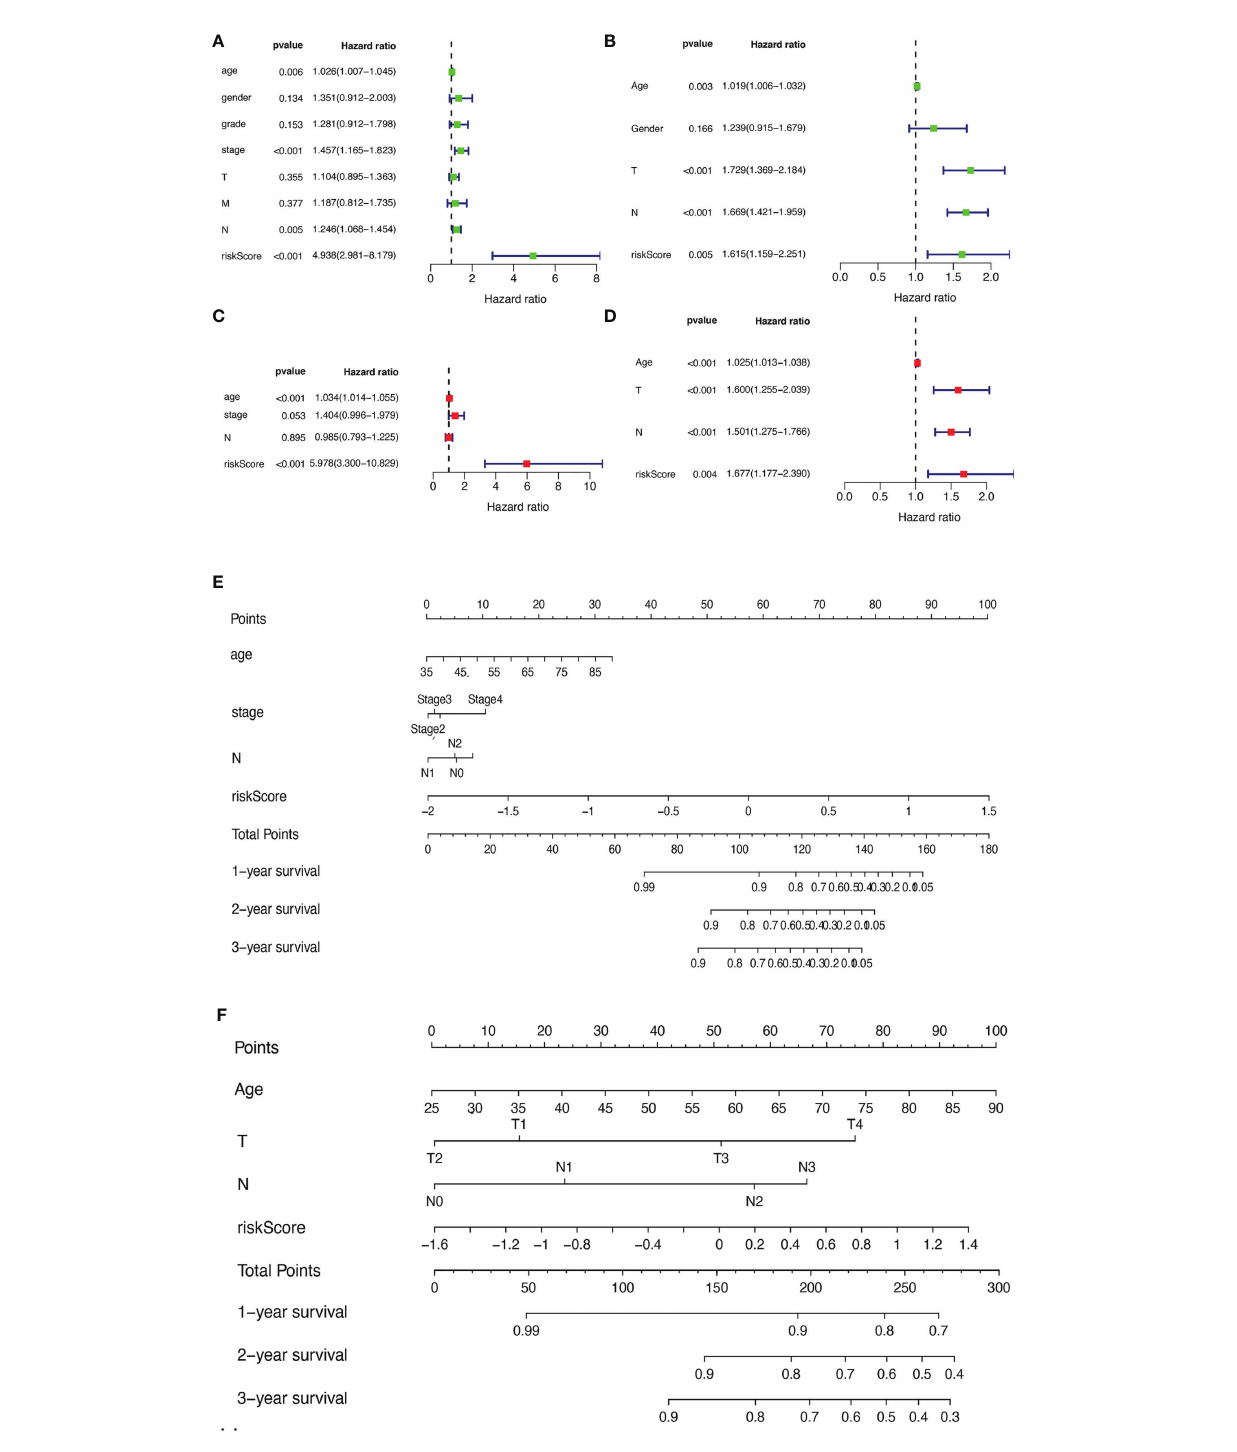
FIGURE 6 | The relevance of clinical features and metabolism-related risk scores in stomach adenocarcinoma (STAD). (A) Univariate Cox regression analysis of risk factors in STAD based on The Cancer Genome Atlas (TCGA) data. (B) Multivariate Cox regression analysis of risk factors in STAD based on TCGA data. (C) Univariate Cox regression analysis of risk factors in STAD based on GEO data. (D) Multivariate Cox regression analysis of risk factors in STAD based on GEO data. (E) The risk score and clinical information assessment nomogram to evaluate STAD prognosis based on TCGA data (1-, 2-, and 3-year survival rates). (F) The risk score and clinical information assessment nomogram to evaluate STAD prognosis based on GEO data (1-, 2-, and 3-year survival